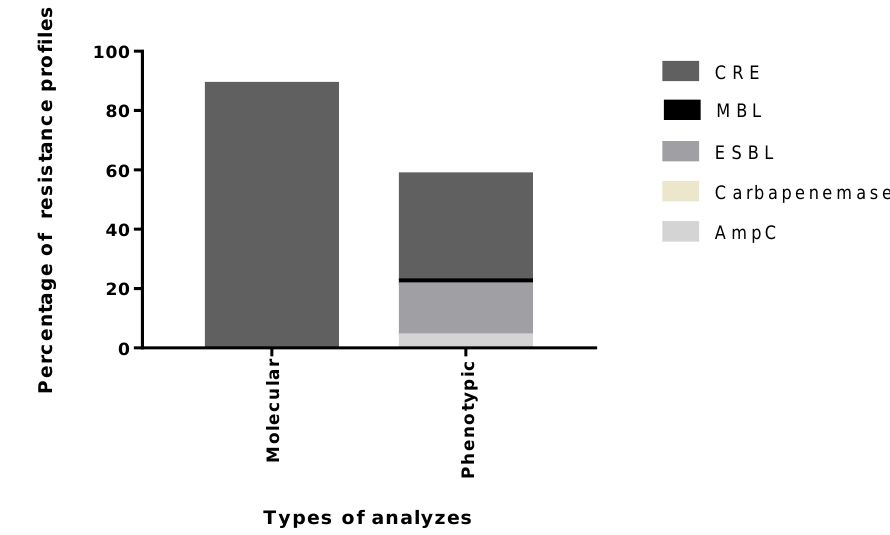
Figure 1. Percentage of profiles of resistance in Enterobacteriaceae.